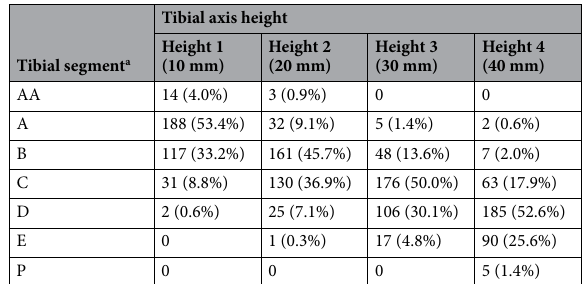
Table 1. Location of the great saphenous vein. a The anterior edge of the tibia to the posteromedial edge was divided into five segments from the anterior edge: A, B, C, D, and E. AA = the segment anterior to the anterior edge and P = the segment posterior to the posterior edge.